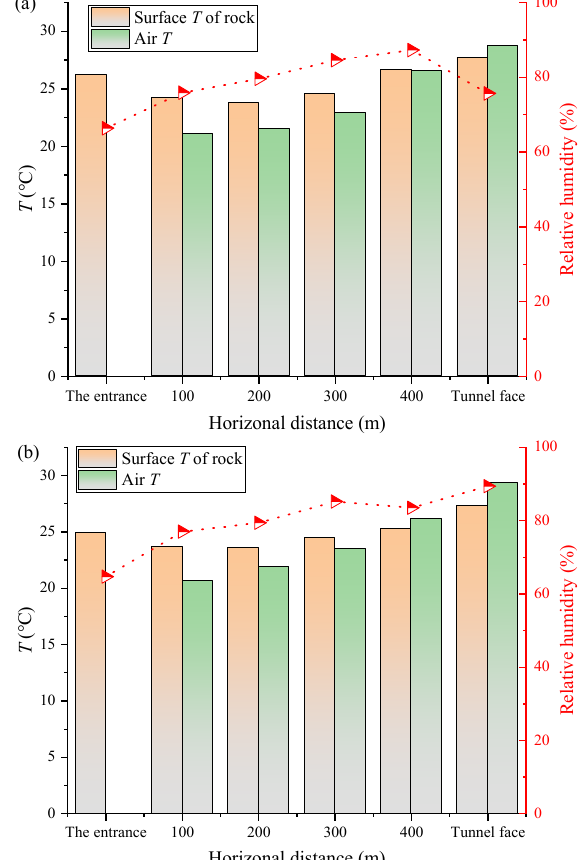
Figure 5. Temperature and relative humidity distribution characteristics at different horizontal distances in the tunnel, in which T is the abbreviation for temperature: ( a ) left tunnel; ( b ) right tunnel.